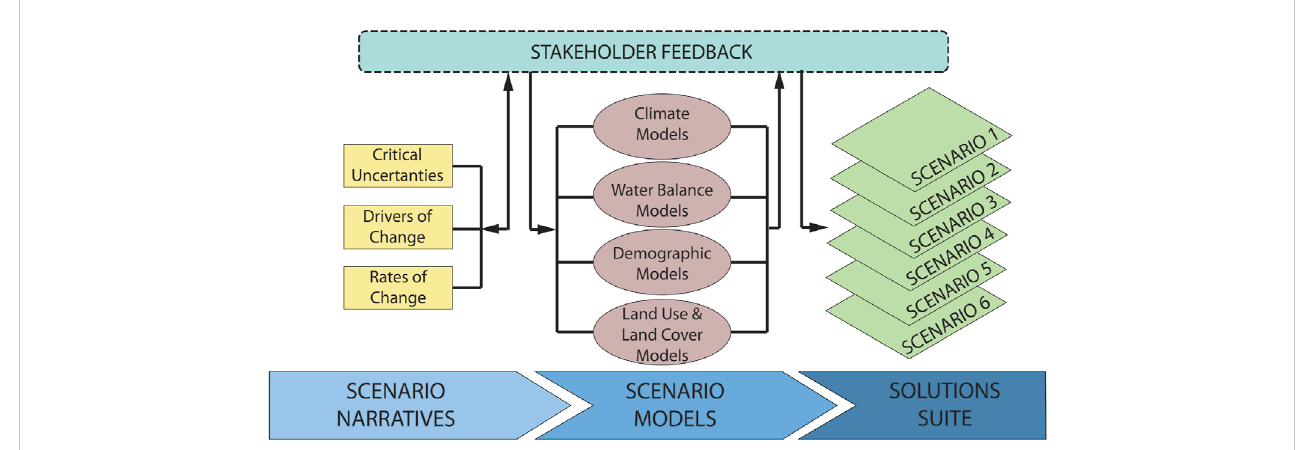
FIGURE 2 Graphic representation of changes in available water and population change and likely solutions and timing of solutions for Happy Valley scenario. Drivers include population change (in beige) and changes in average water availability (blue histograms). “ Model agreement ” refers to the average of multiple climate modelruns, “ model uncertainty ” indicates thevariabilitybetweenthose model runs, and “ model with solutions ” indicates thewater available oncethe identi fi ed solutions are implemented (see Cronan et al., 2022a for more